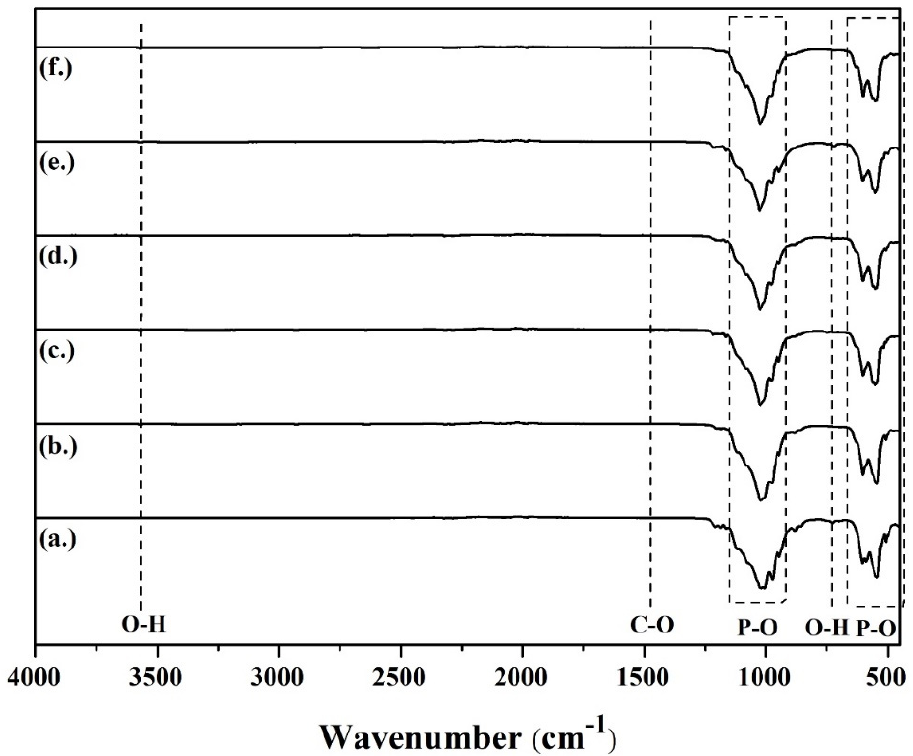
Figure 2. FTIR spectra of biphasic calcium phosphate prepared by cuttlebone with variation of the CMC of L-rhamnose monohydrate biosurfactant: (a) no CMC, (b) 10 CMC, (c) 20 CMC, (d) 100 CMC, (e) 500 CMC and (f) 1000 CMC.